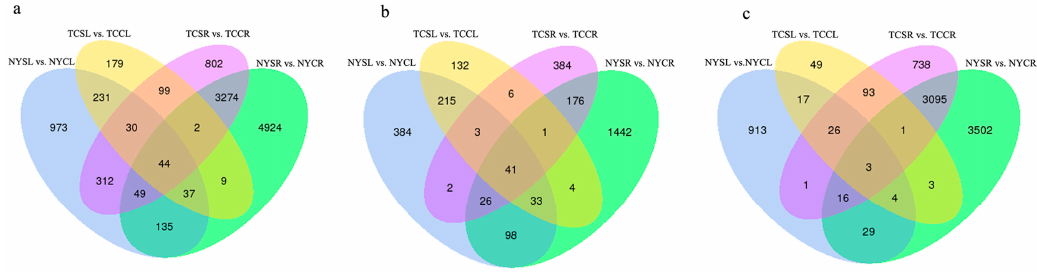
Figure 2. Cluster analysis of differential gene expression profiles in NYCR, NY control root; NYCL, NY control leaf; NYSR, NY salt-stressed root; NYSL, NY salt-stressed leaf; TCCR, TC control root; TCCL, TC control leaf; TCSR, TC salt-stressed root; and TCSL, TC salt-stressed leaf.